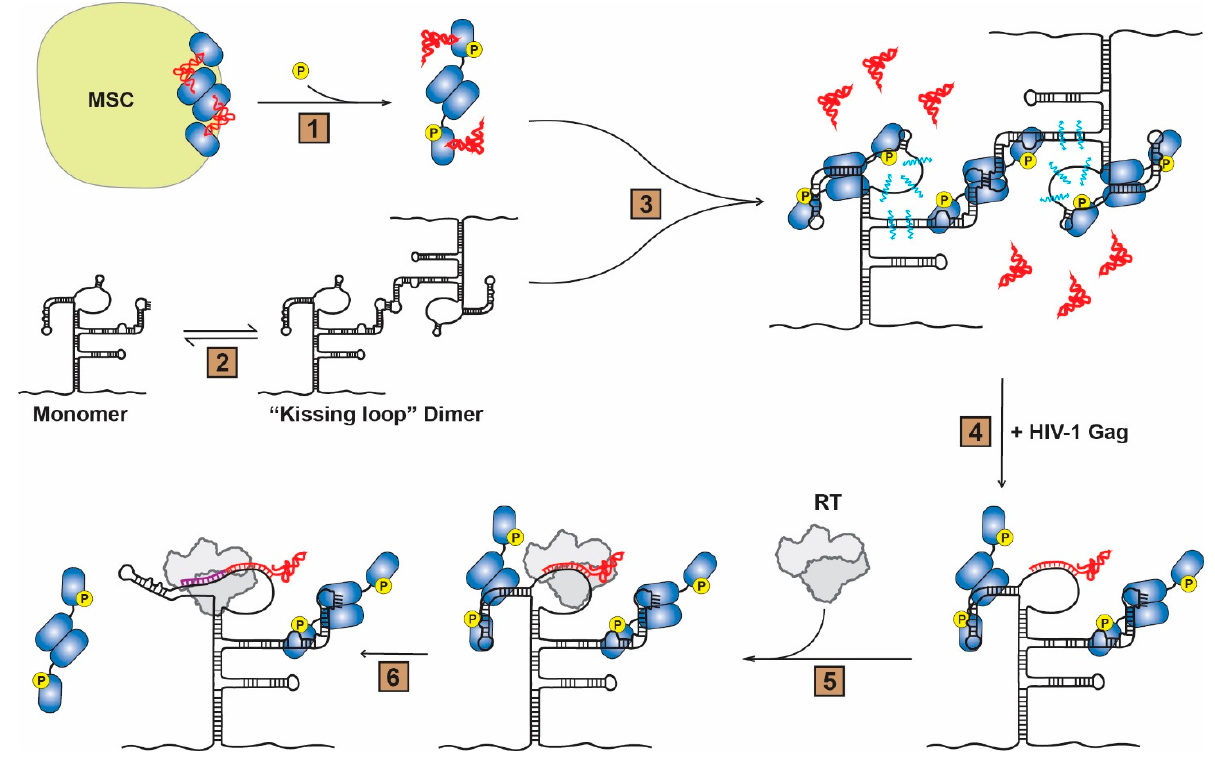
Figure 6. Model of pS207–LysRS-directed primer placement to PBS and subsequent pS207–LysRS release from HIV-1 gRNA. (Step 1) Upon HIV-1 infection, LysRS is phosphorylated on S207 and is released from the multi-aminoacyl-tRNA synthetase complex (MSC) in a conformation inactive for tRNA aminoacylation. (Step 2) The HIV-1 gRNA can adopt various monomeric and dimeric conformations, including the “kissing loop” dimer shown. (Step 3) The catalytically inactive, tRNA- bound pS207–LysRS dimer preferentially binds to the PBS/TLE and SL1 regions of an HIV-1 gRNA dimer. This binding results in release of tRNA from LysRS and an increase in the dynamics of the PBS region and SL1 hairpin (blue squiggles). (Step 4) HIV-1 Gag facilitates annealing of the tRNA primer onto the PBS via chaperone activity of the nucleocapsid domain. (Step 5) After maturation, reverse transcriptase (RT) binds the primer:template complex and (Step 6) initiates proviral DNA synthesis (purple extension) leading to disruption of the TLE conformation and pS207–LysRS release. For clarity, the second gRNA monomer is not shown after Step 4. Figure S1: Native PAGE analysis of DNA-primer-annealed PBS/TLE complexes; Figure S2: Native PAGE analysis of UTR 240 RNAs; Figure S3: Fluorescence anisotropy plots of WT and S207D LysRS( ∆ N65) binding to HIV-1 RNAs; Figure S4: SAXS processing of LysRS-bound PBS/TLE; Figure S5: Results of XL-SHAPE titration of LysRS constructs binding to UTR 240 RNA; Figure S6: SAXS processing of UTR 240 ( ∆ DIS) and UTR 240 ( ∆ DIS, ∆ PBS/TLE) constructs; Figure S7: Fluorescence anisotropy plots of WT and S207D LysRS( ∆ N65) binding to primer-annealed HIV-1 PBS/TLE 105 RNAs; Figure S8: SAXS processing of DNA-primer annealed PBS/TLE; Figure S9: Superposed orthogonal views of all primer-annealed HIV-1 PBS/TLE 105 RNA SAXS-derived ab initio